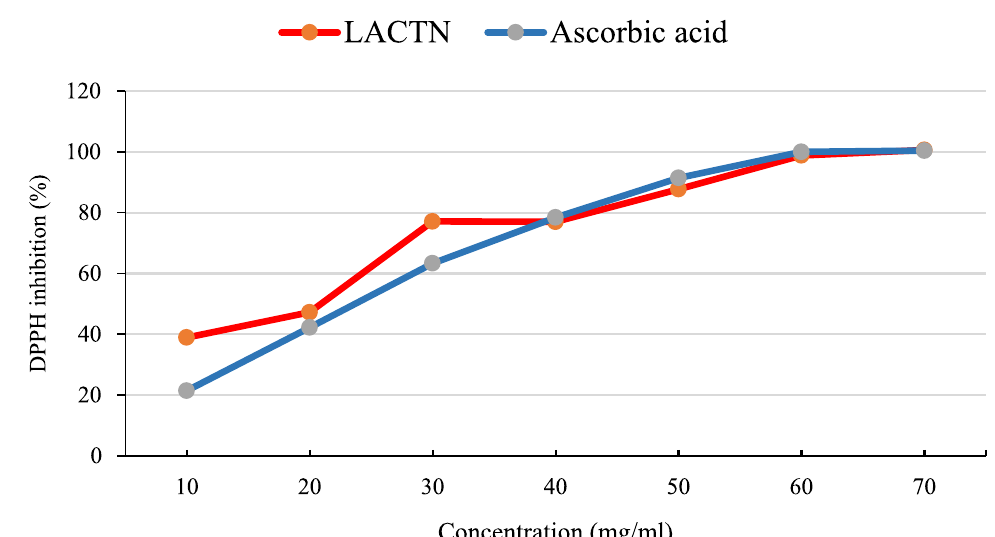
Fig. 1 Percentage inhibitions of DPPH by LACTN and ascorbic